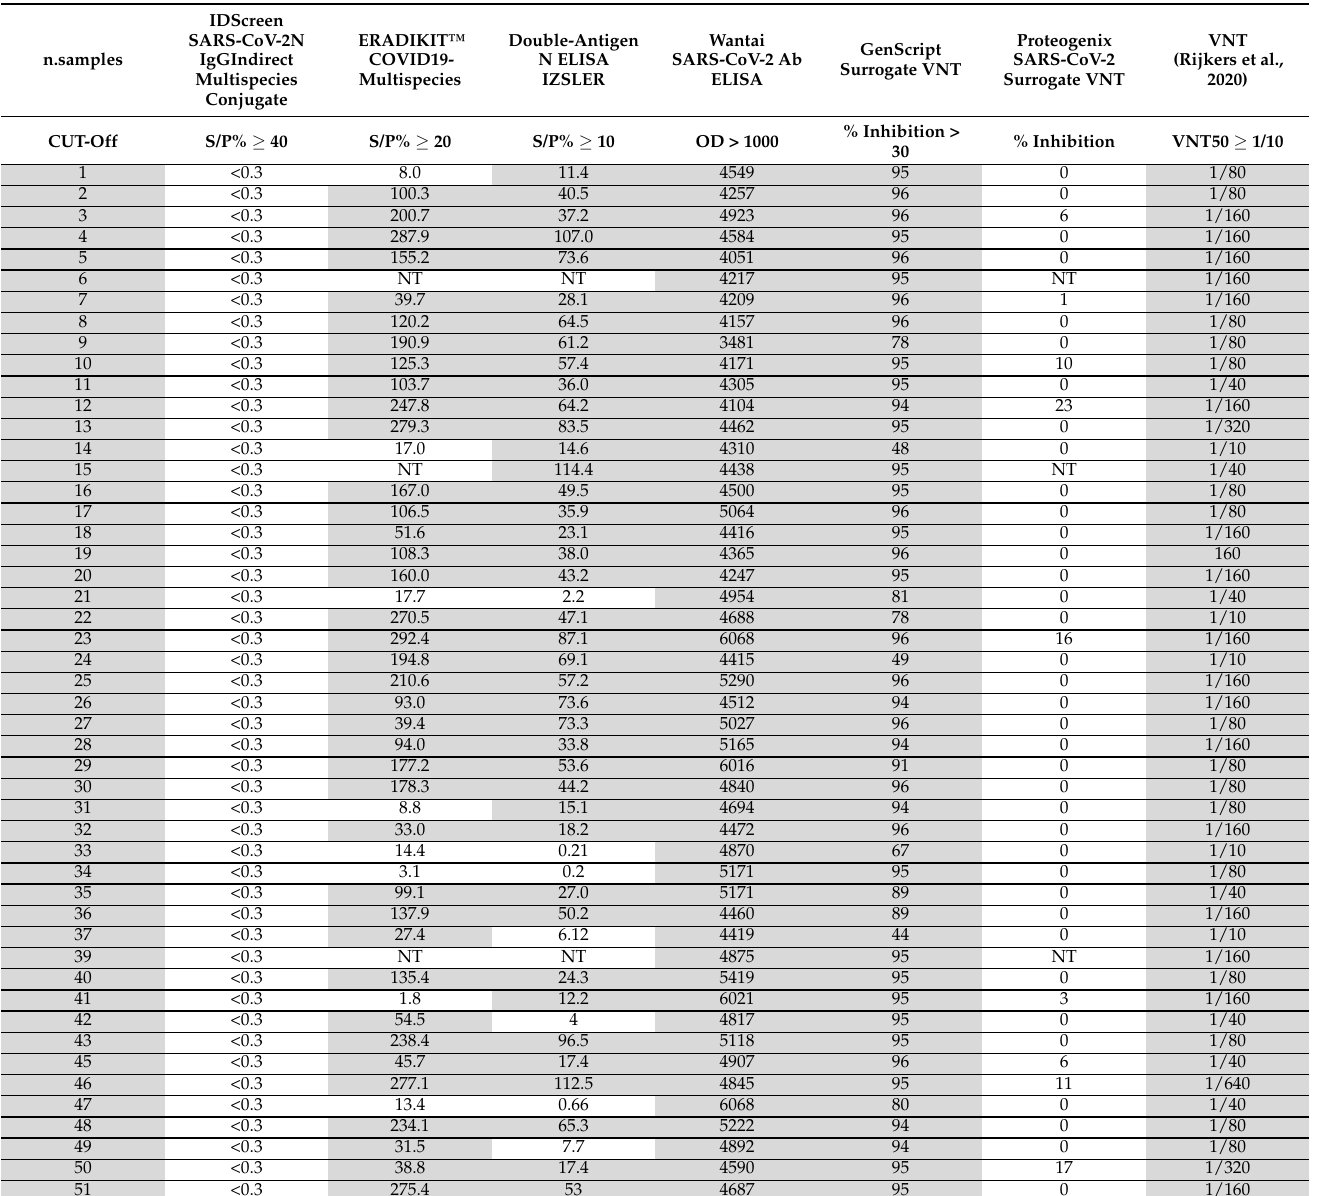
Table 1. Serological results obtained using various tests. Positive results are highlighted in grey. NT: not tested due to insufficient quantity. Serum status is identified with two colours in the column of the number of samples: grey, positive; white, negative. The diagnostic accuracy of each test was calculated with the diagnostic test 2 × 2 table according to serum status using MedCalc software (https://www.medcalc.org, version 20.106, accessed on 30 May 2022) (Se: sensitivity; Sp: